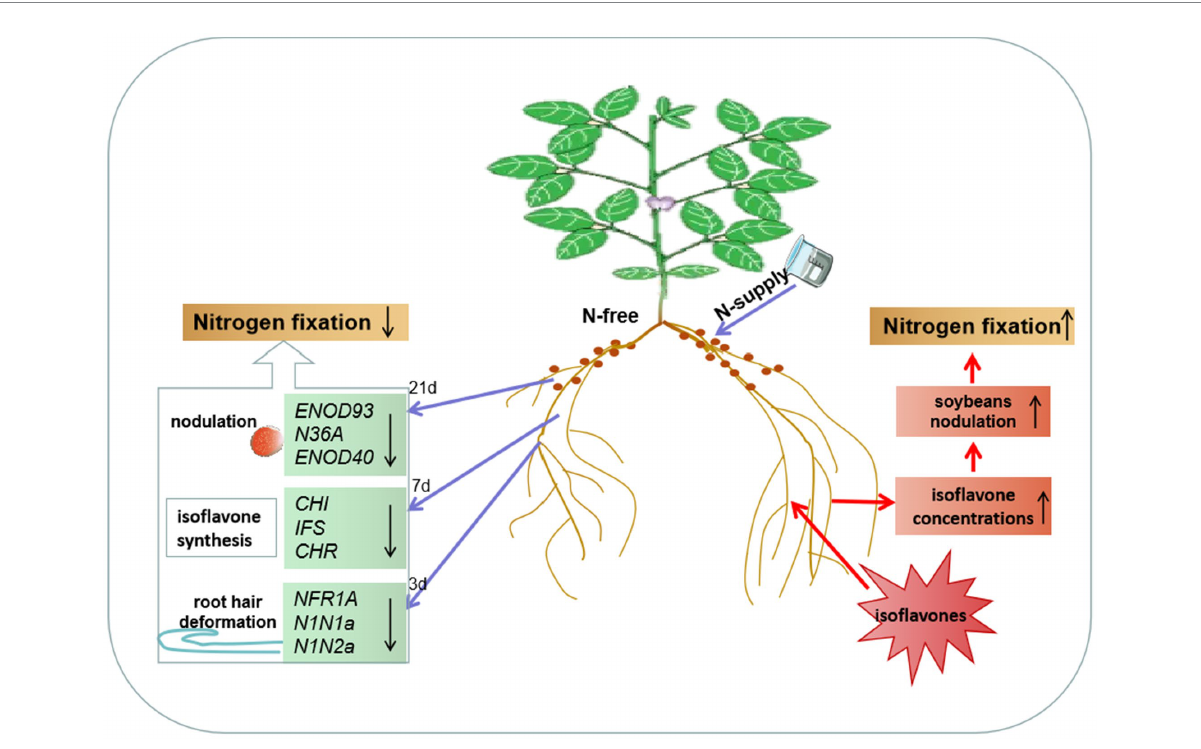
FIGURE 5 N systemically regulates soybean nodulation and N fixation through isoflavones. After unilateral N-supply, the expression of NFR1A , N1N1a, N1N2a , CHI , IFS , CHR, ENOD93 , N36A , and ENOD40 in the roots and nodules of the N-free side was downregulated, which at least partly explained root hair deformation, nodulation and isoflavone synthesis and secretion enhancement changes. Simultaneous, application of isoflavones promoted the isoflavones synthesis on the treated side and N 2 fixation in root nodules. Unilateral N or isoflavones supply, nodulation, nitrogen fixation and nodulation-related genes responded to the changes in root isoflavones concentrations in the same